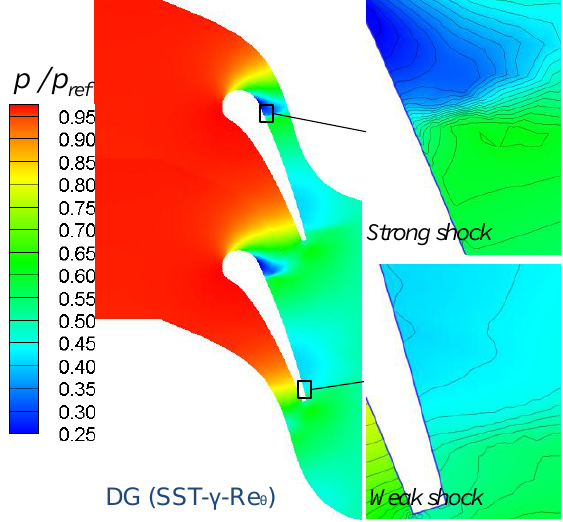
Figure 10. Computed pressure contour of Mark II (SST + γ- Re θ ).